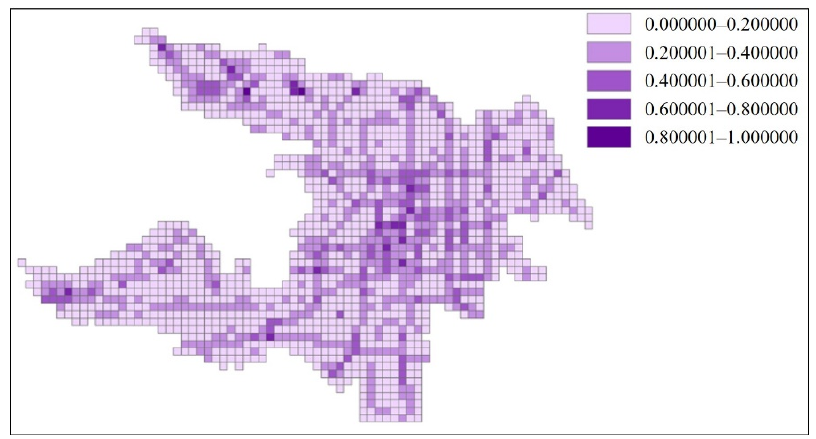
Figure 9. Visualization of the relative internal accessibility of Zhicheng.